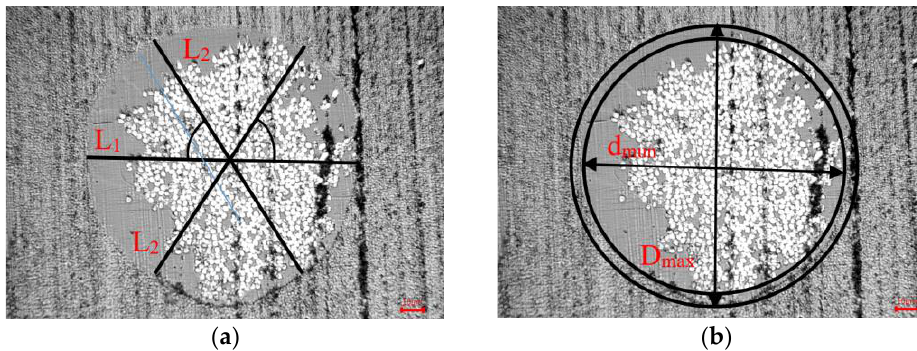
Figure 3. Measuring method for the diameter and roundness of CFRPF. ( a ) Measurement method of diameter. ( b ) Measurement method of roundness.